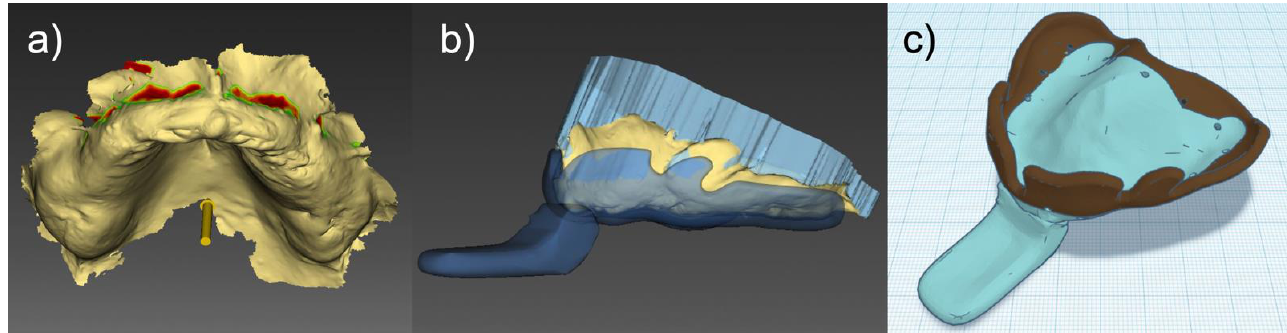
Figure 4. Design of a dual-material customized impression tray. ( a ) intraoral scan with undercuts shown in red, ( b ) finished one-piece custom tray design, ( c ) thermoplastic compound material (brown), and rigid (cyan) parts separated into two STL files .